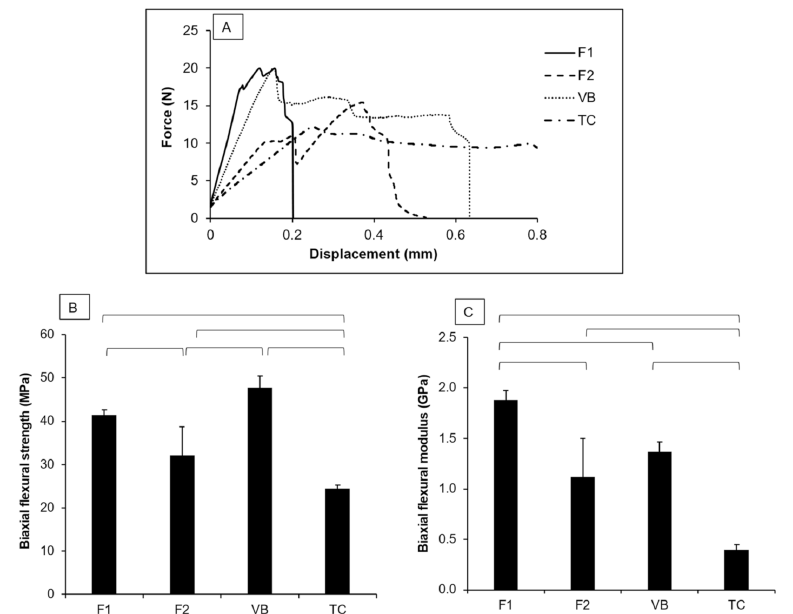
Figure 7. ( A ) Force–displacement of the representative specimens of each group. ( B ) Biaxial flexural strength and ( C ) modulus of the materials after immersion in water for 24 h. Error bars are SD ( n = 5). The lines indicate p < 0.05.